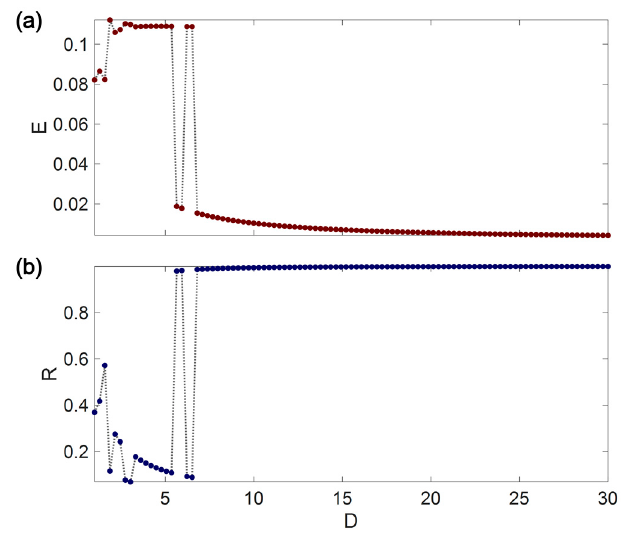
Figure 4. ( a ) The synchronization error and ( b ) parameter R values as a function of the coupling strength. The fractional-order α is 0.75.